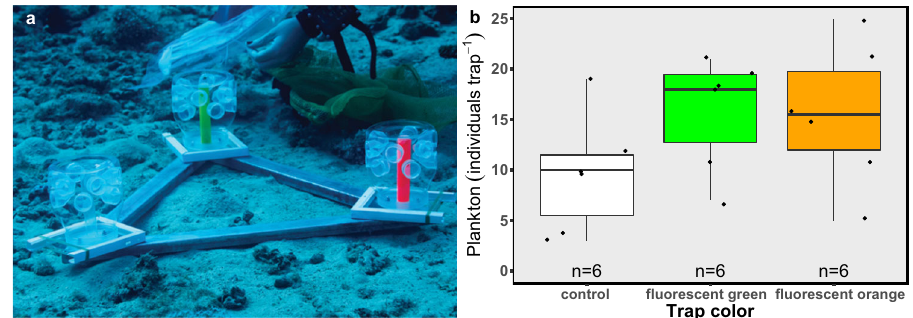
Fig. 4 The attraction of natural plankton to fl uorescent and non- fl uorescent traps. a The experimental setup for the in situ attraction experiment. b The results of the plankton attraction experiment are presented as the number of plankton individuals in each trap ( n = 6 trials). Boxes represent the upper and lower quartile, centerlines represent medians, and whiskers extend to data measurements that are less than 1.5*IQR away from the fi rst/third